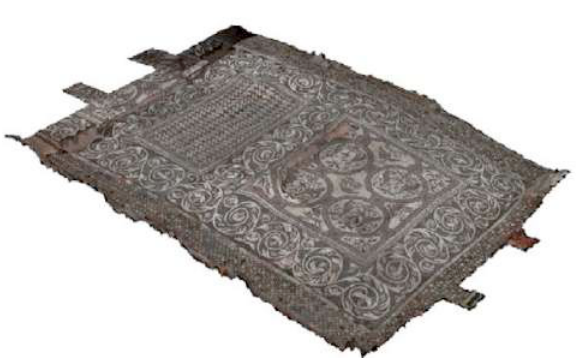
Figure 3. 3D Digital Orthophoto of the experimental area of the San Marco Basilica's floor (Brumana, 2010)